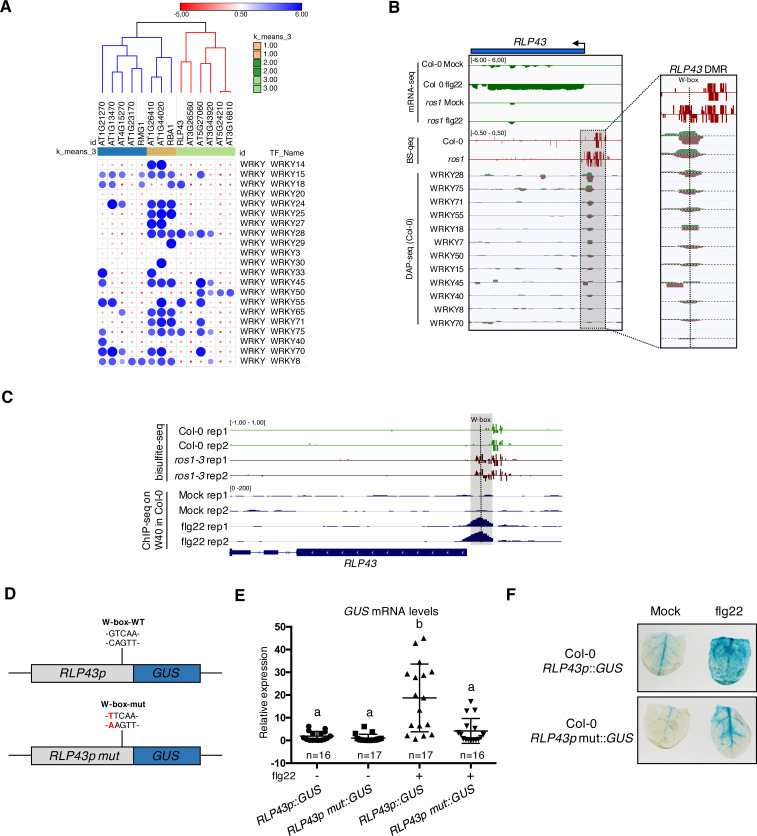
Several WRKY transcription factors bind to the demethylated region of the RLP43 promoter, which contains a functional and flg22-responsive W-box cis-element.(A) A subgroup of the ROS1 targets exhibits an over-representation of WRKY DNA binding at the promoter regions corresponding to the hyperDMRs that were retrieved in ros1-3. GAT analysis performed on publicly available DNA affinity purification sequencing (DAP-seq) data (O'Malley et al., 2016) identified WRKY TFs with significant enrichment in the regions corresponding to the hyperDMRs observed in ros1-3 for the 14 stringent ROS1 primary targets. (B) Several WRKY TFs specifically bind to the region that is demethylated by ROS1 in the RLP43 promoter. Snapshots representing, from top to bottom, mRNA-seq (Rep1), BS-seq (Rep1), and DAP-seq data (O'Malley et al., 2016) at the RLP43 locus. To better appreciate the overlap between the promoter region of RLP43 subjected to ROS1-directed demethylation and the region where WRKY TFs bind to DNA, a zoom in is depicted at the level of the hyperDMR (box on the right panel) and the position of the W-box is highlighted by the vertical dashed line. (C) A hemagglutinin (HA) epitope-tagged version of WRKY40 binds in vivo to the ROS1-targeted region of the RLP43 promoter in a flg22-dependent manner. Snapshots depicting bisulfite sequencing data from 5-week-old rosette leaves of Col-0 and ros1-3 mutant (Rep1) and ChIP-seq data performed on seedlings of wrky40 mutants (SLAT collection of dSpm insertion line; Shen et al., 2007) complemented with WRKY40-HA treated with either mock (medium without flg22) or flg22 (medium supplemented with flg22) for 2 hr, at RLP43 (Birkenbihl et al., 2017). (D) Scheme representing the RLP43 transcriptional GUS fusion constructs containing the WT W-box sequence (RLP43p::GUS) and the mutated W-box sequence (RLP43p mut::GUS). (E) The W-box cis-element at the RLP43 promoter is functional and responsive to flg22. RT-qPCR analyses were performed to monitor the GUS mRNA levels in primary T1 transformants expressing either the RLP43p::GUS or RLP43p mut::GUS transgenes. For each individual, two leaves were syringe-infiltrated with mock (water) and two other leaves were treated the same way with flg22 at a concentration of 1 μM for 6 hr. The GUS mRNA levels are relative to the level of UBQ transcripts. Statistical significance was assessed using a one-way ANOVA test and a Tukey’s multiple comparisons test. (F) The flg22-induced GUS activity is impaired in RLP43p mut::GUS-elicited plants. GUS-staining of 5-week-old rosette leaves of RLP43p::GUS or RLP43pmut::GUS primary transformants that were syringe-infiltrated with either mock or 1 μM of flg22 for 24 hr. Representative pictures are shown.Figure 4—source data 1.Original qRT-PCR data of GUS transcript quantification for Figure 4E.